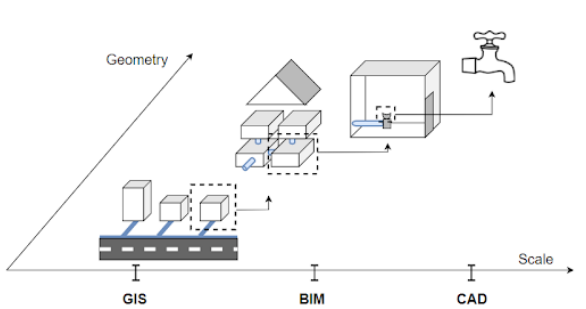
Figure 1. Possible representation of CMMS assets from geospatial